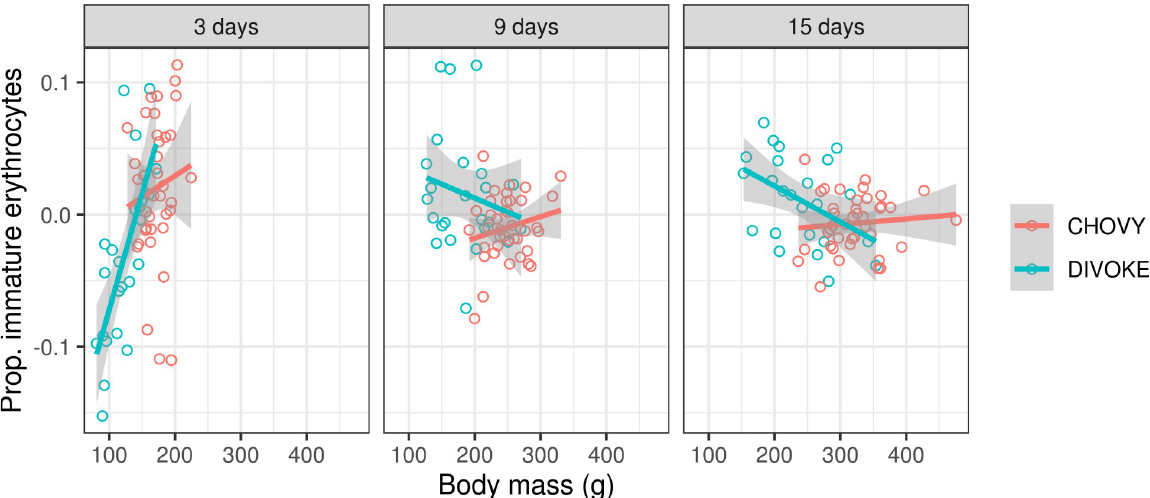
Fig 5. Variation in the proportion of immature erythrocytes in wild and farmed mallard, including variation due to the effects of body mass and age (n wild = 24, n farmed = 40). Analysis was adjusted for other variables present in the minimal adequate model. Individual observations correspond to model residuals. Model predictions and 95% confidence intervals are